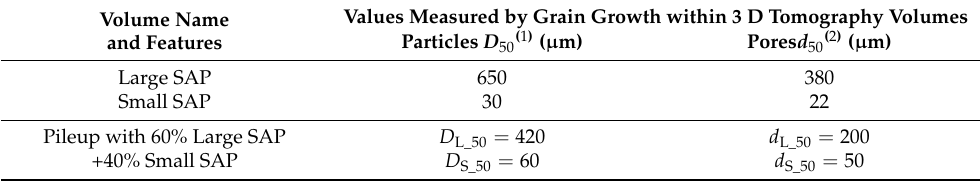
Table 2. Inter-Particle pores and Superinsulating Aerogel Particles, average sizes measured with a 3D grains growth procedure and X-ray tomography.